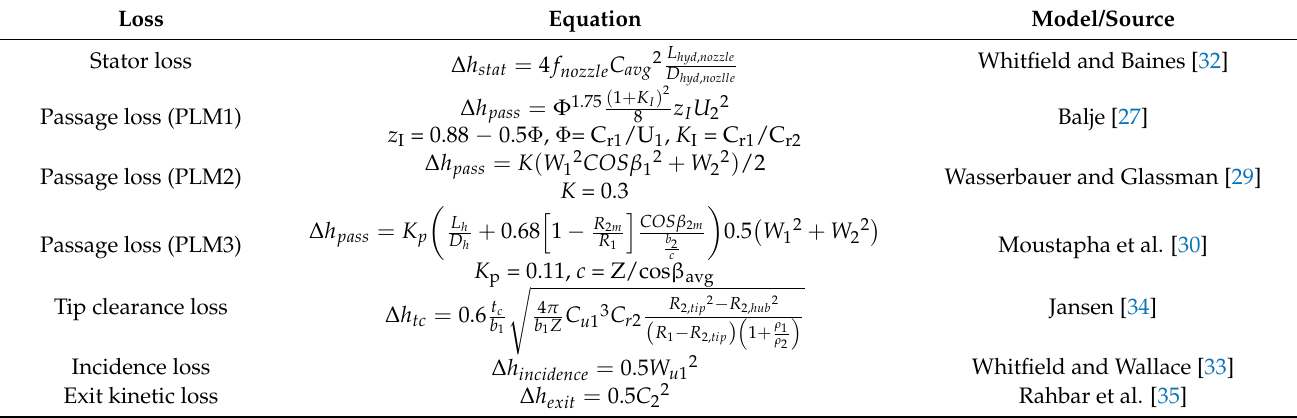
Table 1. Summary of enthalpy loss correlations used in the radial turbine